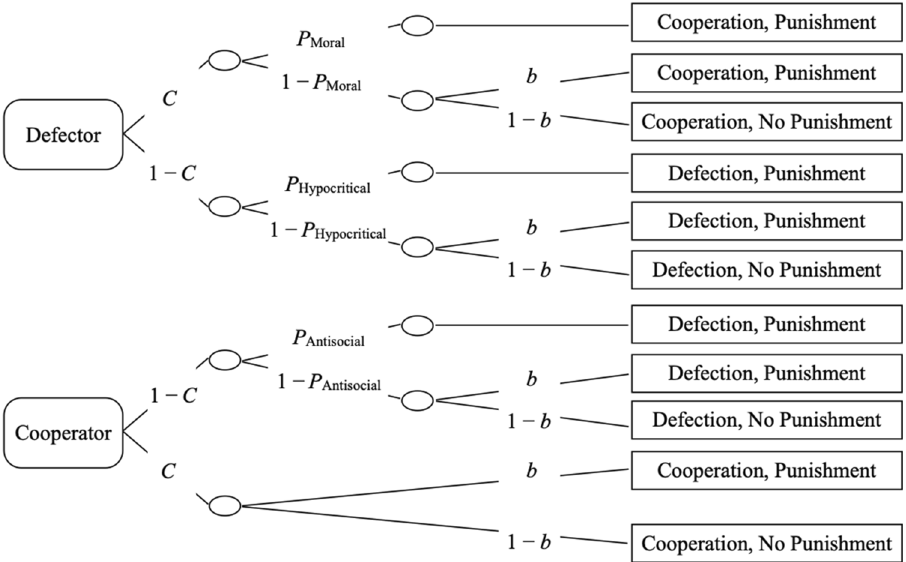
Figure 3. The multinomial model of cooperation and punishment. Rounded rectangles on the left side represent the partners’ behaviors in the Prisoner’s Dilemma game. Rectangles on the right represent the participants’ behaviors. The model was used to estimate the probability of the participants’ cooperation ( C ), conditional probabilities for different types of punishment ( P Moral , P Hypocritical , and P Antisocial ), and the participants’ bias to punish ( b